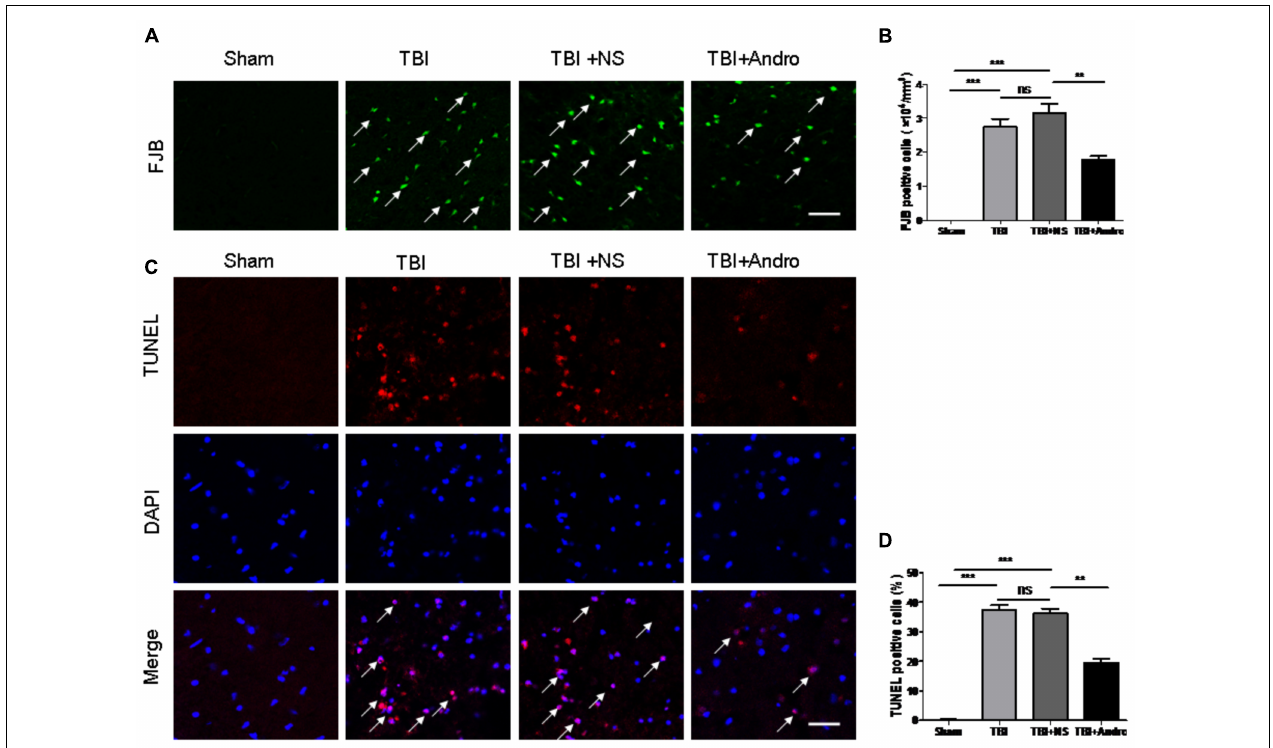
FIGURE 2 | Andro treatment decreased the number of neuronal degeneration and apoptosis after TBI. (A) Degenerating neurons were detected with Fluoro-Jade B staining at 24 h after TBI. Arrows indicated the FJB-positive cells. (B) Percentage of FJB-positive cells around the injured brain tissues. (C) Apoptotic cells were labeled with TUNEL staining at 24 h after TBI. Arrows indicated the TUNEL-positive cells. (D) Percentage of TUNEL-positive cells around the injured brain tissues. Data are presented as the mean ± SD. ∗ p < 0.05, ∗∗ p < 0.01 ∗∗∗ p < 0.001, ns p > 0.05; n = 6 in each group. Scale Bars = 50 µ m.